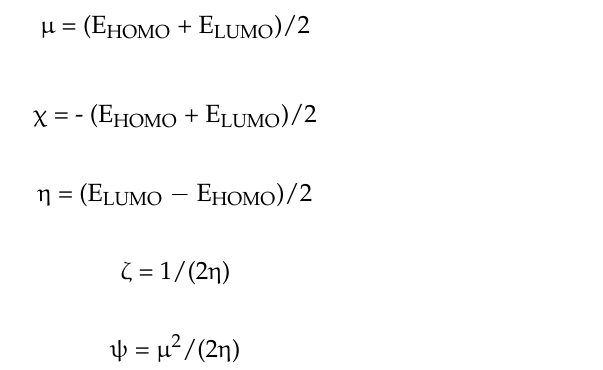
Table 4. Chemical potential (µ), electronegativity (χ), hardness (η), softness (ζ), electrophilicity in- dex (ψ) for (+) - catechin, betulinic acid, ursolic acid, quercetin - 3 - O - galactoside, luteo- lin - 7 - O - glucoside, and myricetin.